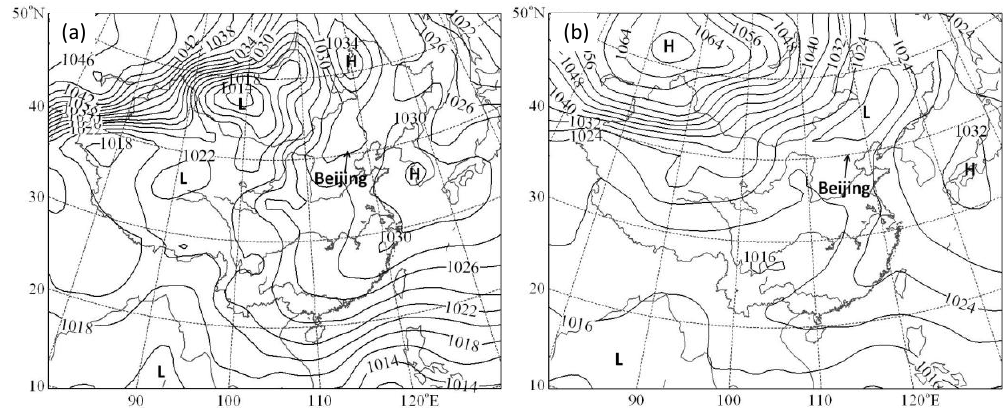
Fig.2. Surface weather patterns at 08:00 a.m. on (a) 18 January 2010 and (b) 19 10 Fig. 2. Surface weather patterns at 08:00 (LT) on (a) 18 January 2010 and (b) 19 January 2010. drawn into a 5 ml syringe, filtered by a syringe filter, and in- jected into a polymeric vial with filter cap. The polymeric vials were put into a Dionex AS-DV Autosampler and an- alyzed by an ion chromatography (ICS-1000, DIONEX) for , water-soluble ions (Na + , NH + , K + , Mg 2 + , Ca 2 + , Cl − , NO − 3 4 ) and SO 2 − 4